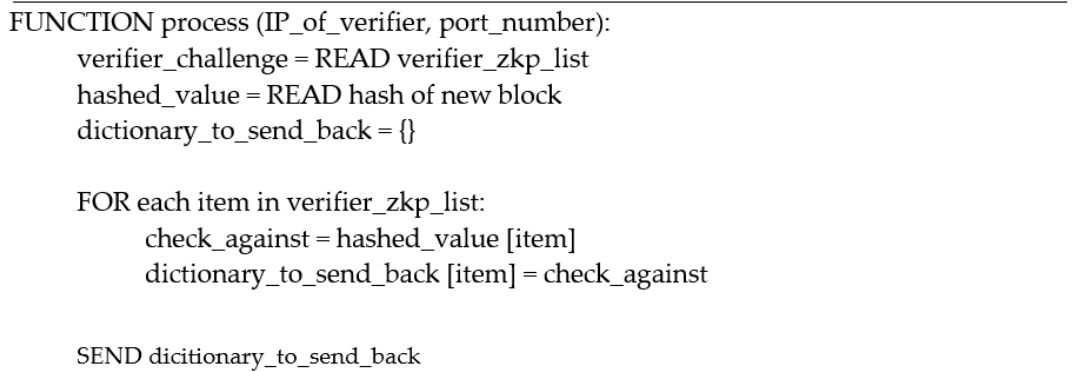
Figure 13. Pseudo code of prover for the zero-knowledge challenge. Figure 14. Example of the completed positional hash value of ZKP.